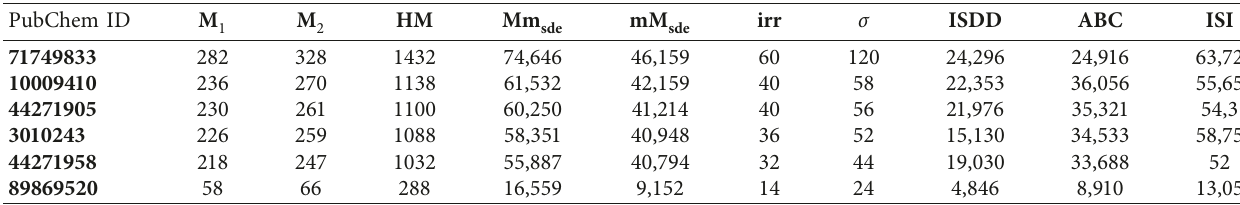
Table 3: The values of topological indices of the molecular structures of potential drugs to be used in the treatment of COVID-19. PubChem ID M 1